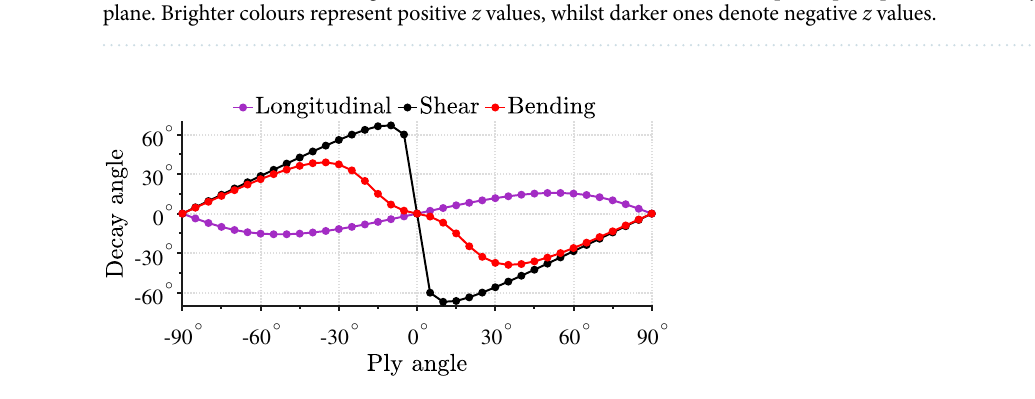
Figure 4. Decay direction angles of various evanescent waves as a function of a ply direction angle in an orthotropic plate with material parameters from Table